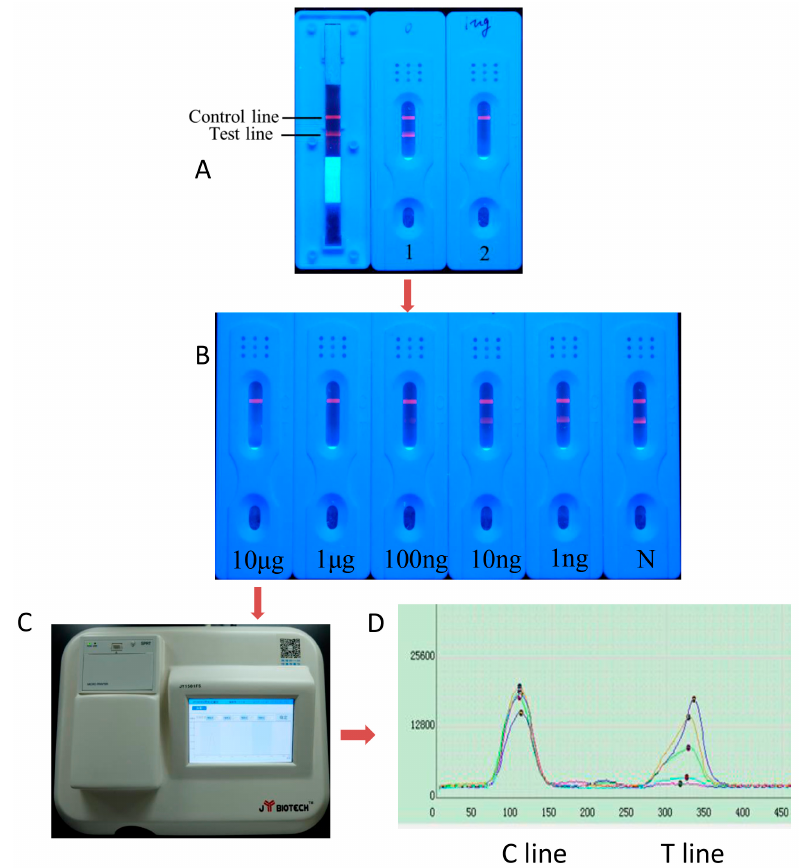
Figure 4. Characterization of the lateral flow immunoassay for PUE. ( A ) Results obtained using the ITS test for puerarin showing negative ( A1 ) and positive ( A2 ) samples in ultraviolet light. Fluorescence appeared at both the test and control lines if a sample was free of puerarin. Fluorescence appeared only at the control line if a sample was positive for puerarin; ( B ) Photographs of results for standard solutions containing different concentrations of puerarin assayed using the ICS; ( C ) Photograph of the matched scanning luminoscope; ( D ) The fluorescent intensity pattern scanned by the luminoscope [91].